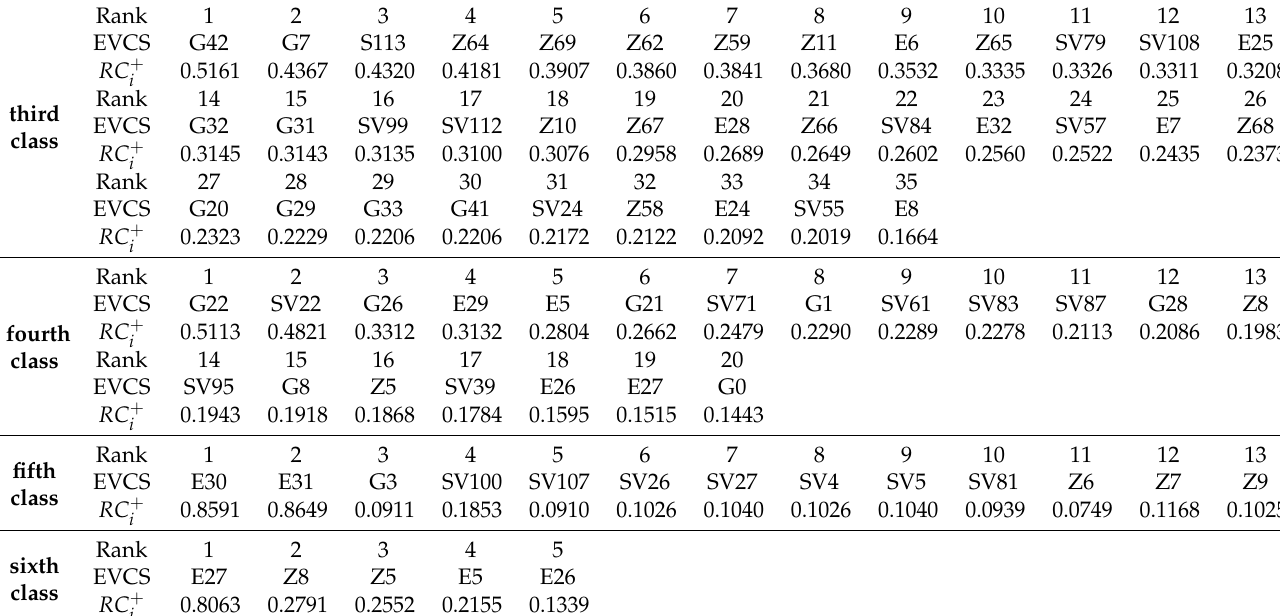
Table 6. Ranking of best and worst current EVCSs in, third, fourth, fifth, and sixth